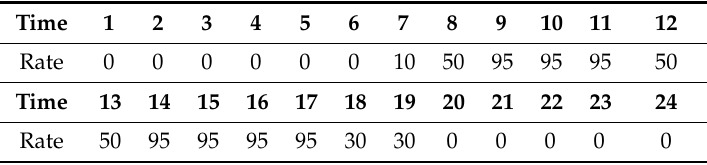
Table 13. Calculate time and appliance hourly rate